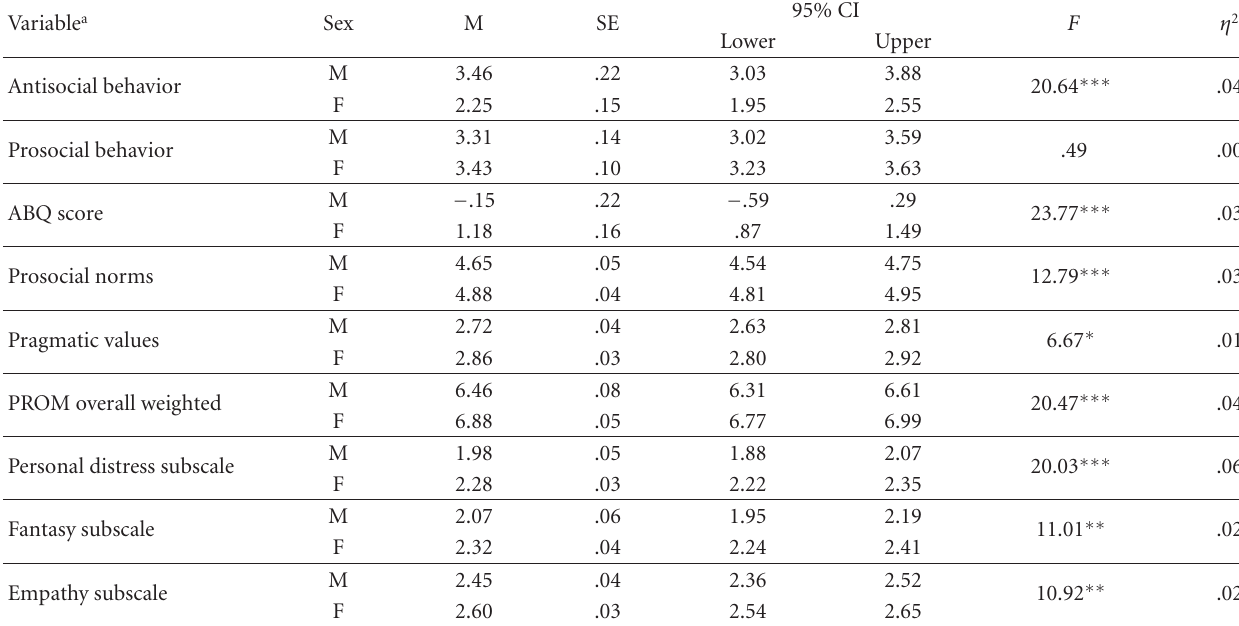
Table 1: Sex di ff erences in prosocial behavior and its correlates.